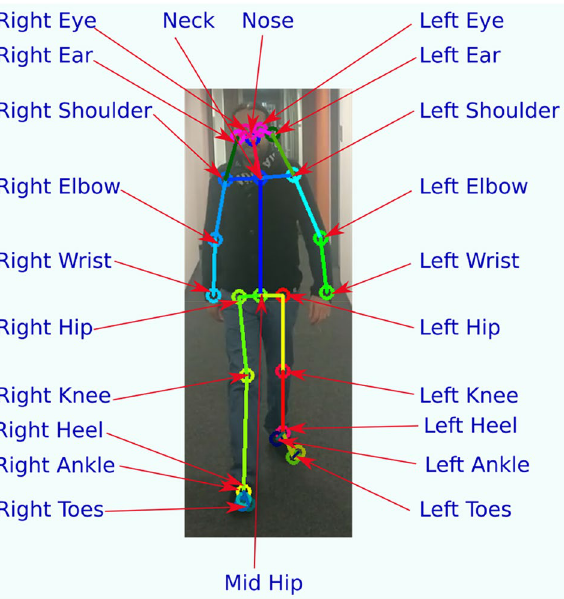
Figure 4. Sample frame with estimated skeleton in